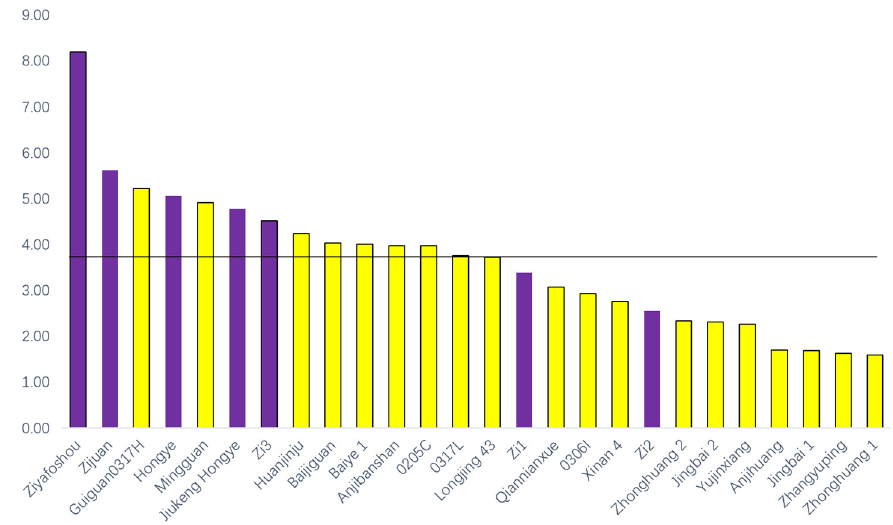
Figure 3. Polyphenol/amino acid content of 26 tea cultivars. The purple bar shows the data from 7 purple-red cultivars, and the yellow bar is the data from yellow-white cultivars. The horizontal line is the PP/AA of ‘Longjing 43’.